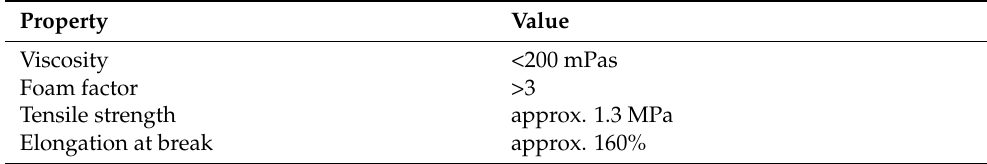
Table 2. Properties of tested